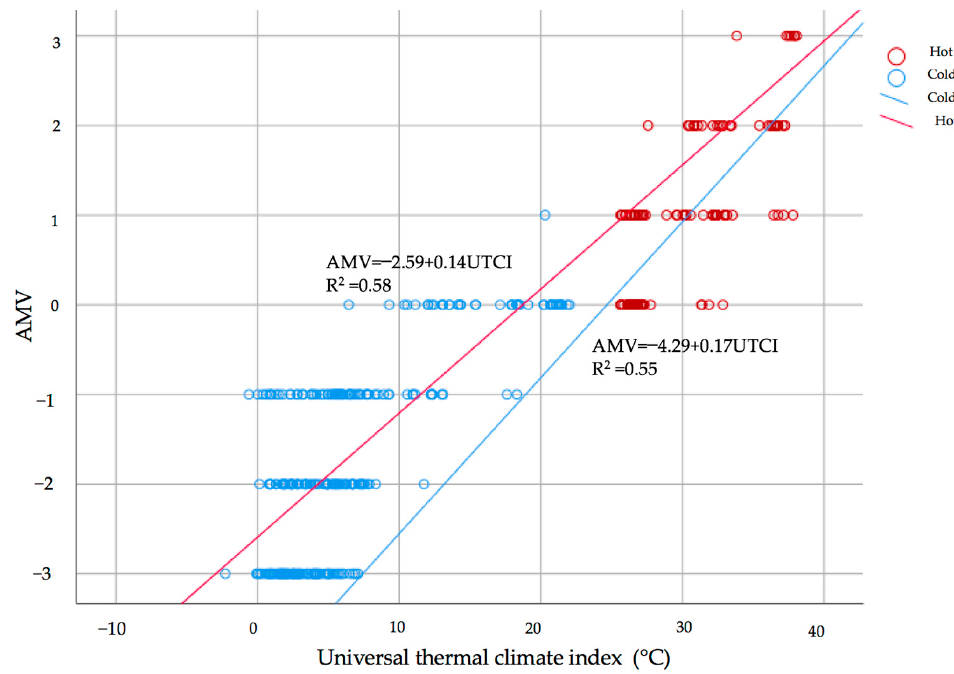
Figure 9. The correlation coefficients between PMV, PET, SET*, UTCI, and AMV show that the best choices for predicting thermal comfort are PET and UTCI during cold seasons and PMV and PET during hot seasons in Tehran.